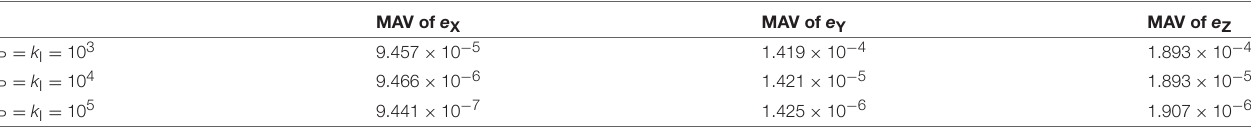
TABLE 2 | Maximal absolute value (MAV) of Cartesian error synthesized by the proposed NTOA scheme (6) with constant noise considered and with different k P and k I values used. # MAV of e